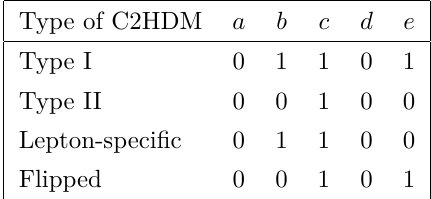
Table 2 . The powers a, b, c, d, e of eq. (2.34) for each type of